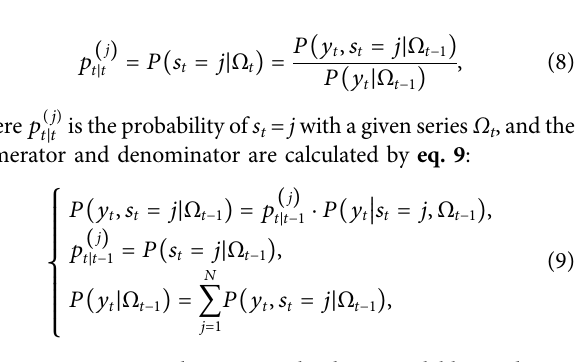
FIGURE 2 | Probability of three states (three models) at each